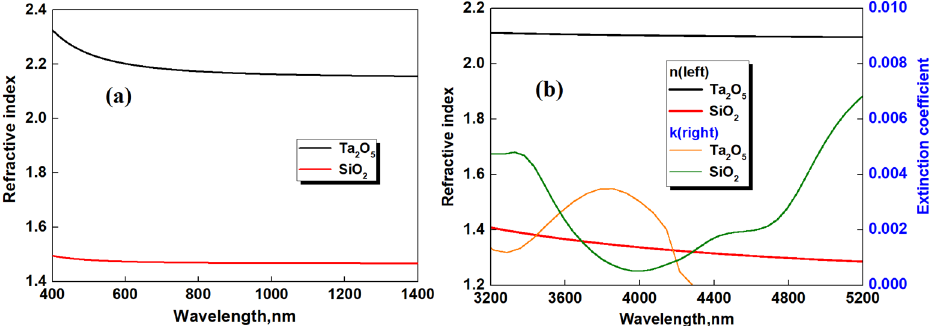
Figure 2. Refractive indices and extinction coefficients of Ta 2 O 5 and SiO 2 layers in the range 400–1400 nm ( a ) and 3200–5200 nm ( b ).